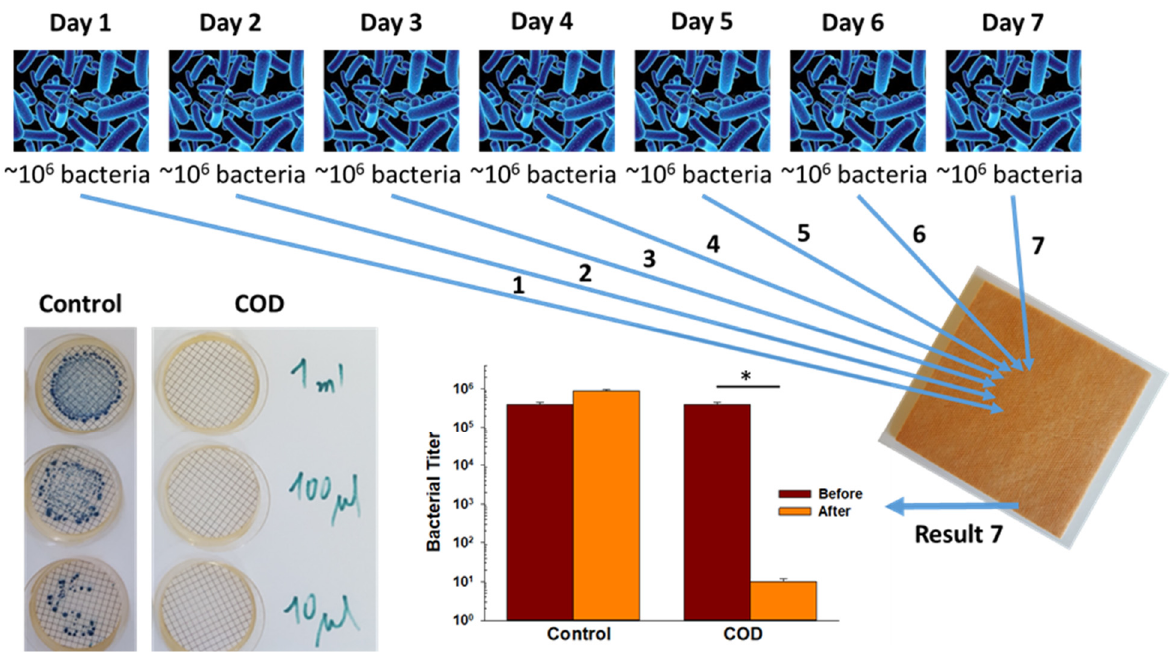
Figure 3. Biocidal efficacy of naturally aged COD for 3 years. Swatches of 7 months, 15 months, and 3 years naturally aged 3-layer COD were inoculated with ~2 × 10 6 CFU of Enterobacter aerogenes . Above 10,000-fold reductions were obtained with all COD tested after 3 h of incubation. The statistical differences in the microbial titers obtained at 3 h of incubation between the negative control and for each naturally aged COD were examined by One Way Analysis of Variance, followed by Holm-Sidak method (a vs. b, p < 0.001). The statistical differences between the microbial titers obtained at 3 h of incubation and the initial titer (0 h) for each naturally aged COD were examined by t -tests. * = p < 0.001; a = mean and standard deviation of the titer retrieved from the Control Dressings at 3 h of incubation; b = mean and standard deviation of the titer retrieved from the COD at 3 h of incubation.